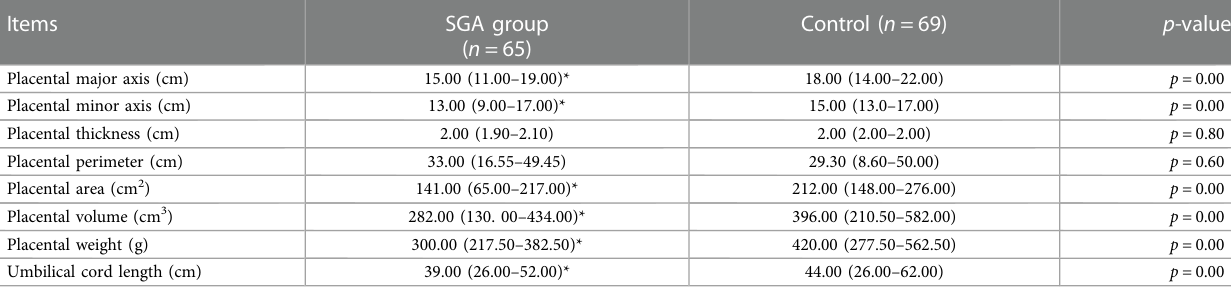
TABLE 2 Comparison of morphological features of the placenta and umbilical cord length between small for gestational age and appropriate for gestational age groups within 10 min after birth. Items